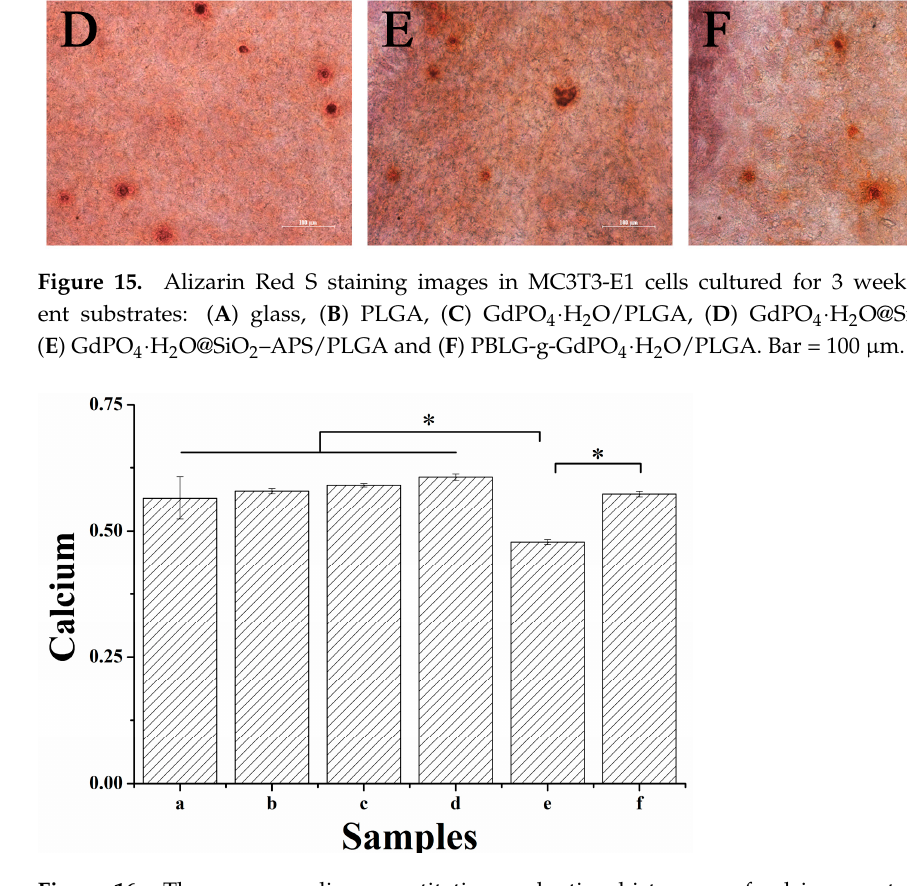
Figure 16. The corresponding quantitative evaluation histogram of calcium content for mineral deposition after Alizarin Red S staining on different substrates: (a) glass, (b) PLGA, (c) GdPO 4 · H 2 O/PLGA, (d) GdPO 4 ·H 2 O@SiO 2 /PLGA, (e) GdPO 4 ‧ H 2 O@SiO 2 –APS/PLGA and (f) PBLG-g-GdPO 4 ·H 2 O/PLGA. * p < 0.05.